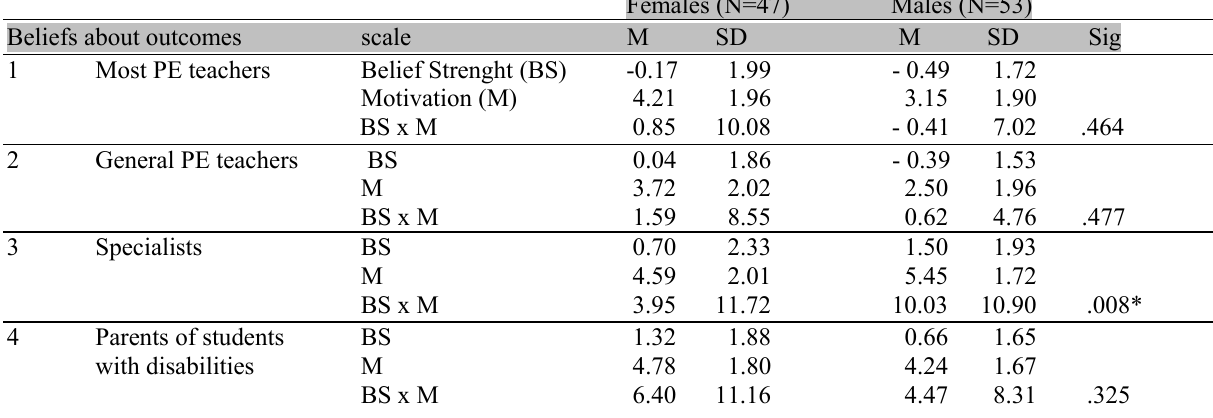
Table 2 . Scores of female and male in-service PE teachers on Normative Beliefs Females (N=47) Males (N=53) Beliefs about outcomes scale M SD M SD